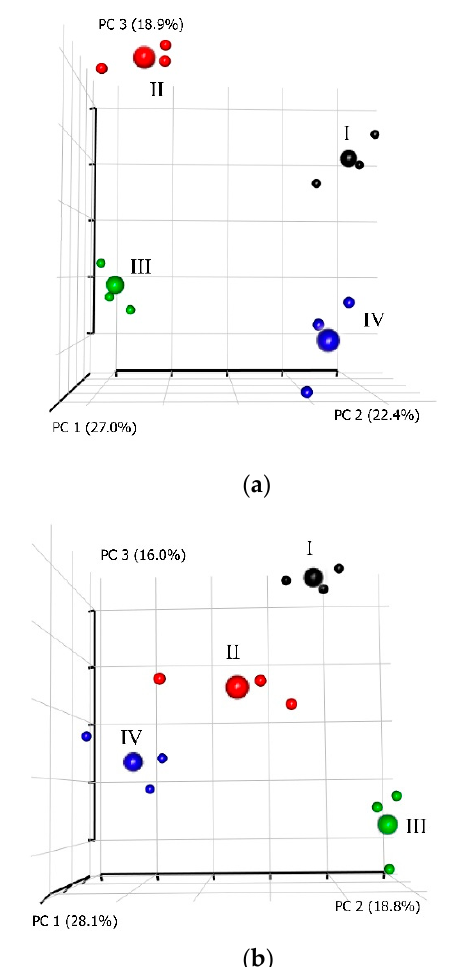
Figure 4. Principal components analysis of the samples by a complex of characters represented as three-dimensional graphs (one point corresponds to one hen, the mean values for each subgroup being shown as the fourth point of the larger diameter) at 1 ( a ) and 7 dpi ( b ) in the subgroups: I (negative control), II (SE challenge), III (Intebio ® intake), and IV (Intebio ® intake + SE challenge).